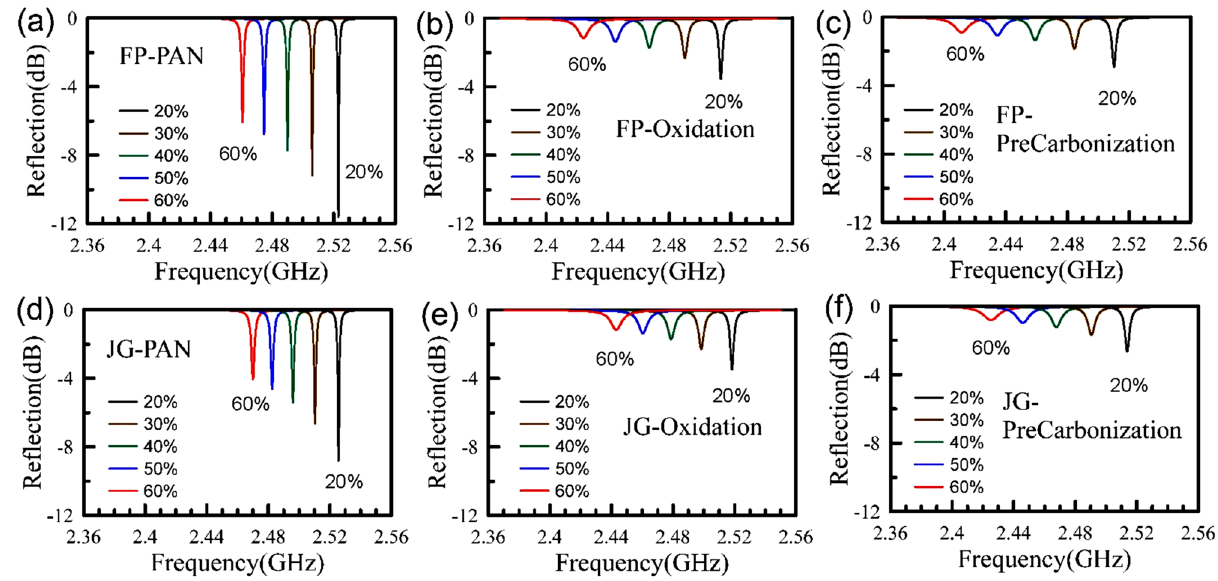
Figure 1. The measured reflection responses using EFM for Formosa Plastic in three stages: ( a ) PAN, ( b ) oxidation, and ( c ) pre-carbonization; and Jing Gong in three stages: ( d ) PAN, ( e ) oxidation, and ( f ) pre- carbonization. In each part, five different volumetric percentages from 20 to 60% are